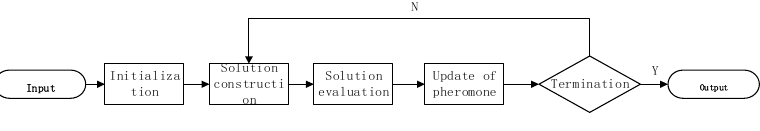
Figure 1. Basic process chart of ant colony algorithm.